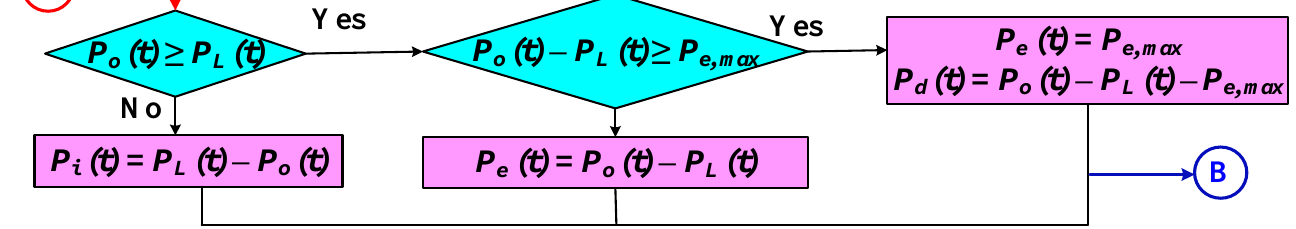
Figure 2. Rule-based home energy management system for PV only system.